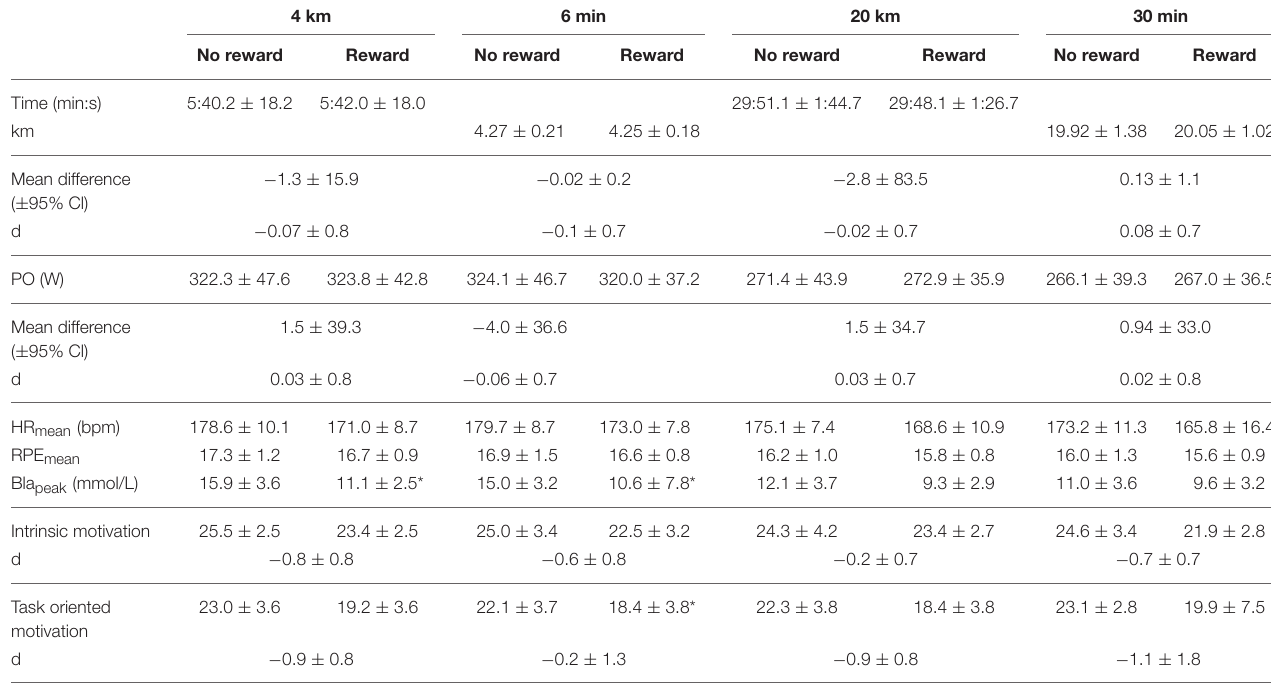
Mean ± standard deviation; Cohen’s effect size (d). * denotes significantly different to non-rewarded group.